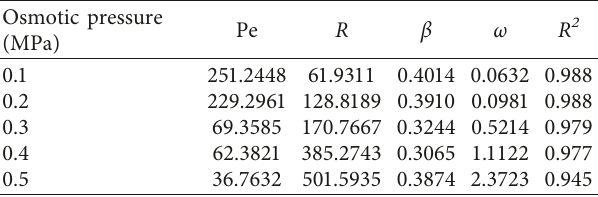
Figure 7: The two-site model simulation results. Pressure: (a) 0.1MPa; (b) 0.2MPa; (c) 0.3 MPa; (d) 0.4 MPa; (e) 0.5MPa. Table 6: The fitting values of the dimensionless parameters in the two-site model.